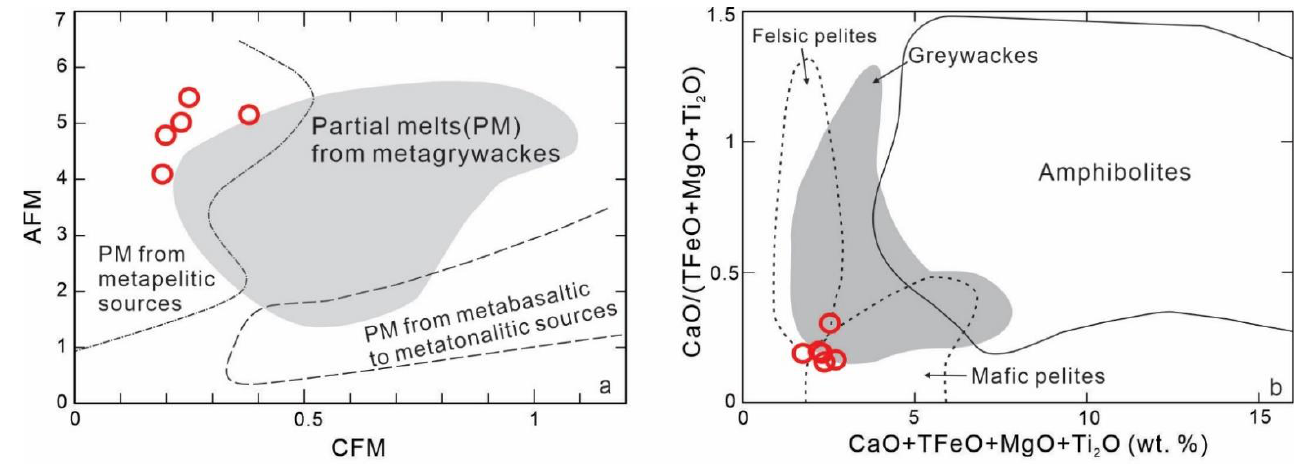
Figure 7. Diagrams for the petrogenesis of the Zhaojinggou monzogranite. ( a ) AMF (molar Al 2 O 3 /(MgO + TFeO)) versus CMF (molar CaO/(MgO + TFeO)) diagram (from [25]); ( b ) CaO/(TFeO + MgO + TiO 2 ) versus CaO+TFeO+MgO+TiO 2 diagram (modified from [30]).